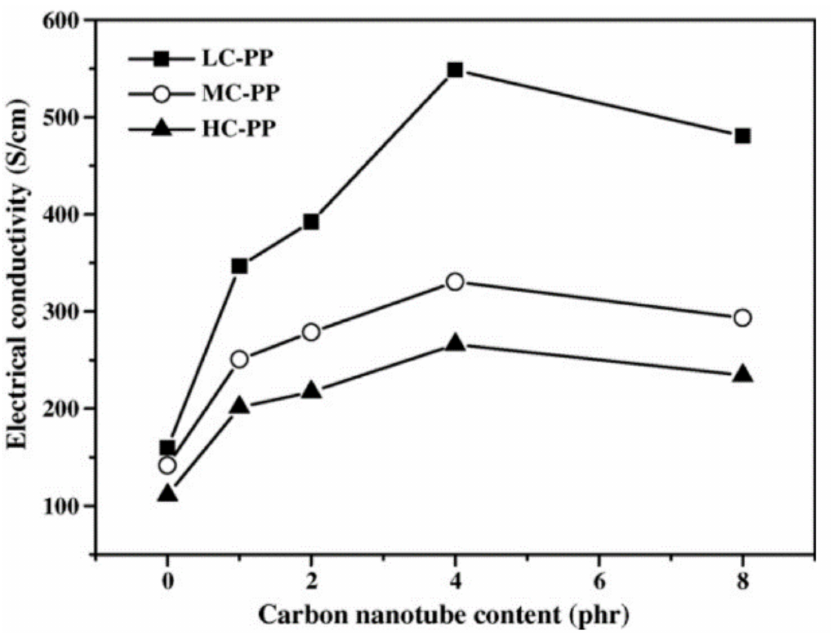
Figure 7. The bulk electrical conductivities of the nanocomposite bipolar plates with various MWCNT contents [59]. Reproduced with